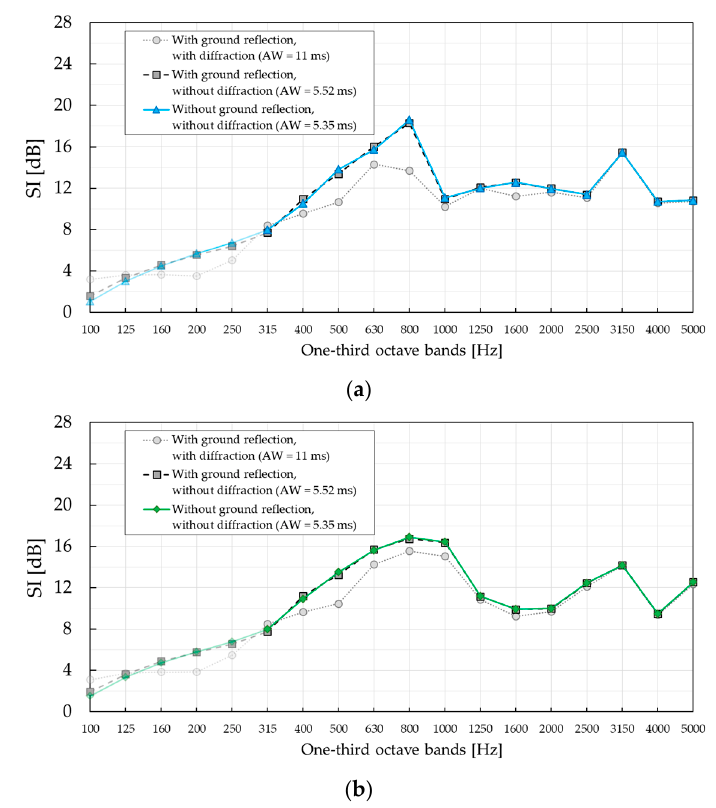
Figure A1. Influence of Adrienne temporal window width on SI measurements in two configurations. ( a ) Sound insulation index SI , configuration A; ( b ) sound insulation index SI , configuration B.